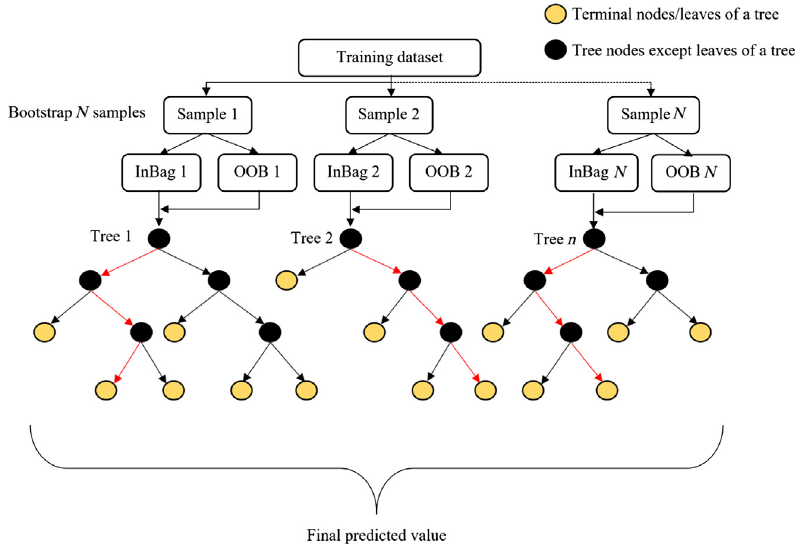
Figure 2. Structure of a random forest with N trees.